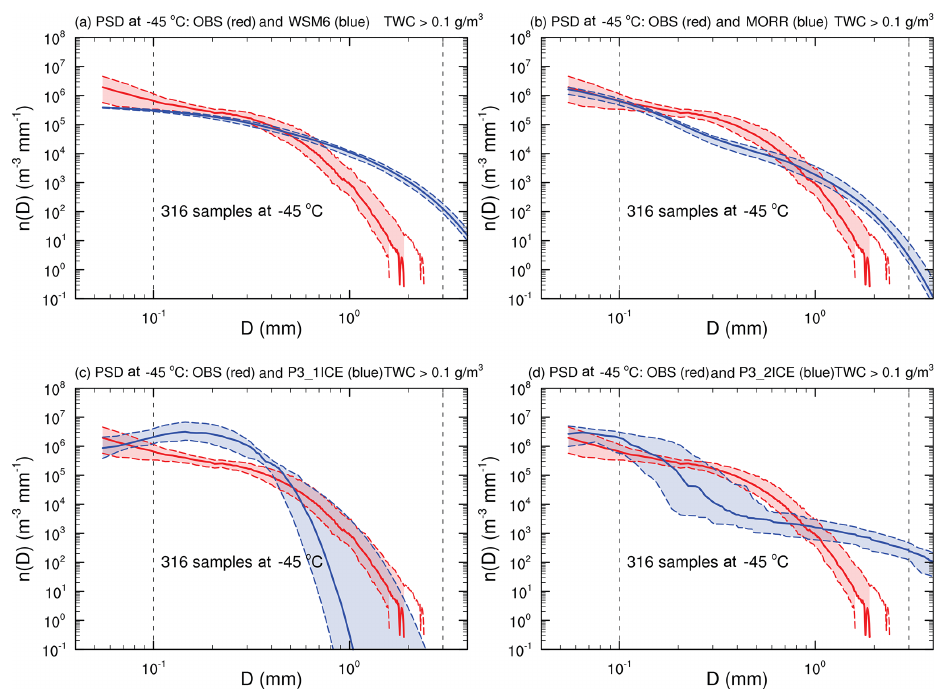
Figure 8. Observed (red) and simulated (blue, a : WSM6, b : MORR, c : P3-1ICE, d : P3-2ICE) ice particle size distributions at the level of − 45 ◦ C. The red and blue dashed lines indicate the 25th and 75th percentiles, and the red and blue solid lines represent the median.